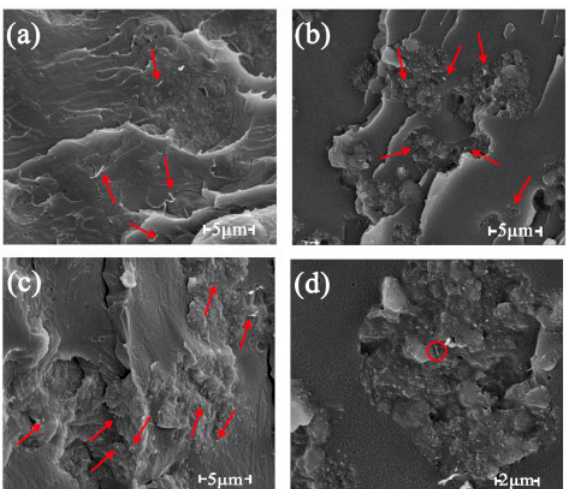
Figure 4. SEM observation of the fracture surfaces of composites with different MWCNT content: ( a ) 6 wt %, ( b ) 9 wt %, and ( c ) 12 wt %; ( d ) the 10,000 × magnification SEM image of the composite with 9 wt % MWCNTs.